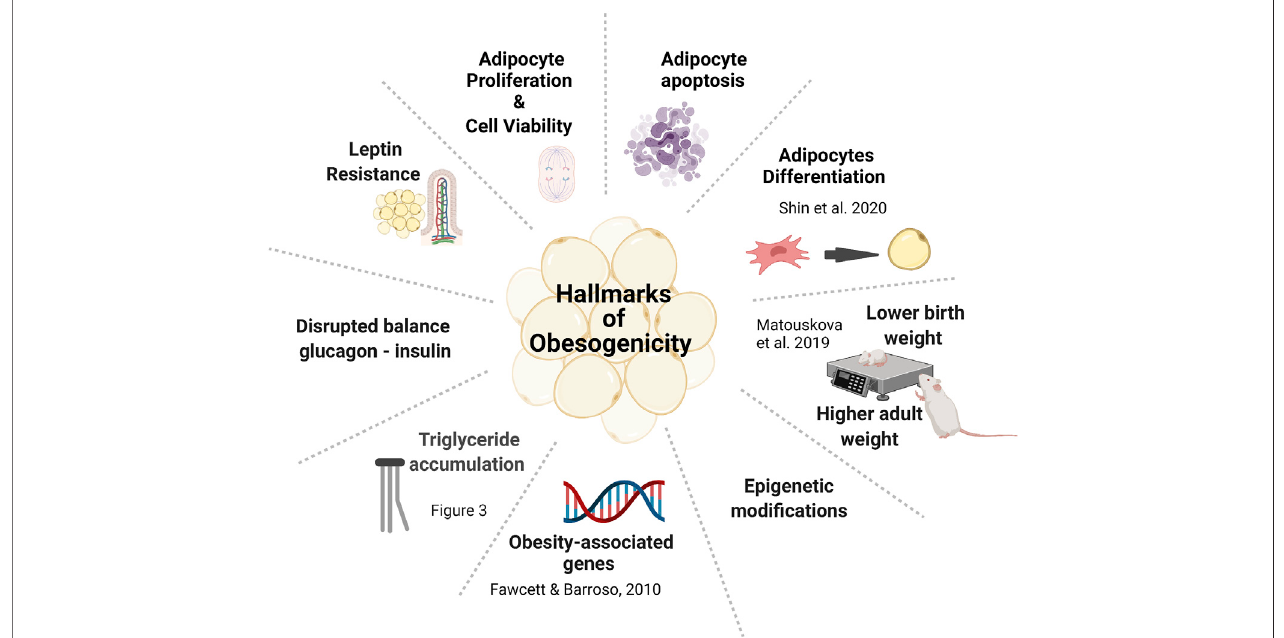
FIGURE 6 | Hallmarks of obesogenesis for